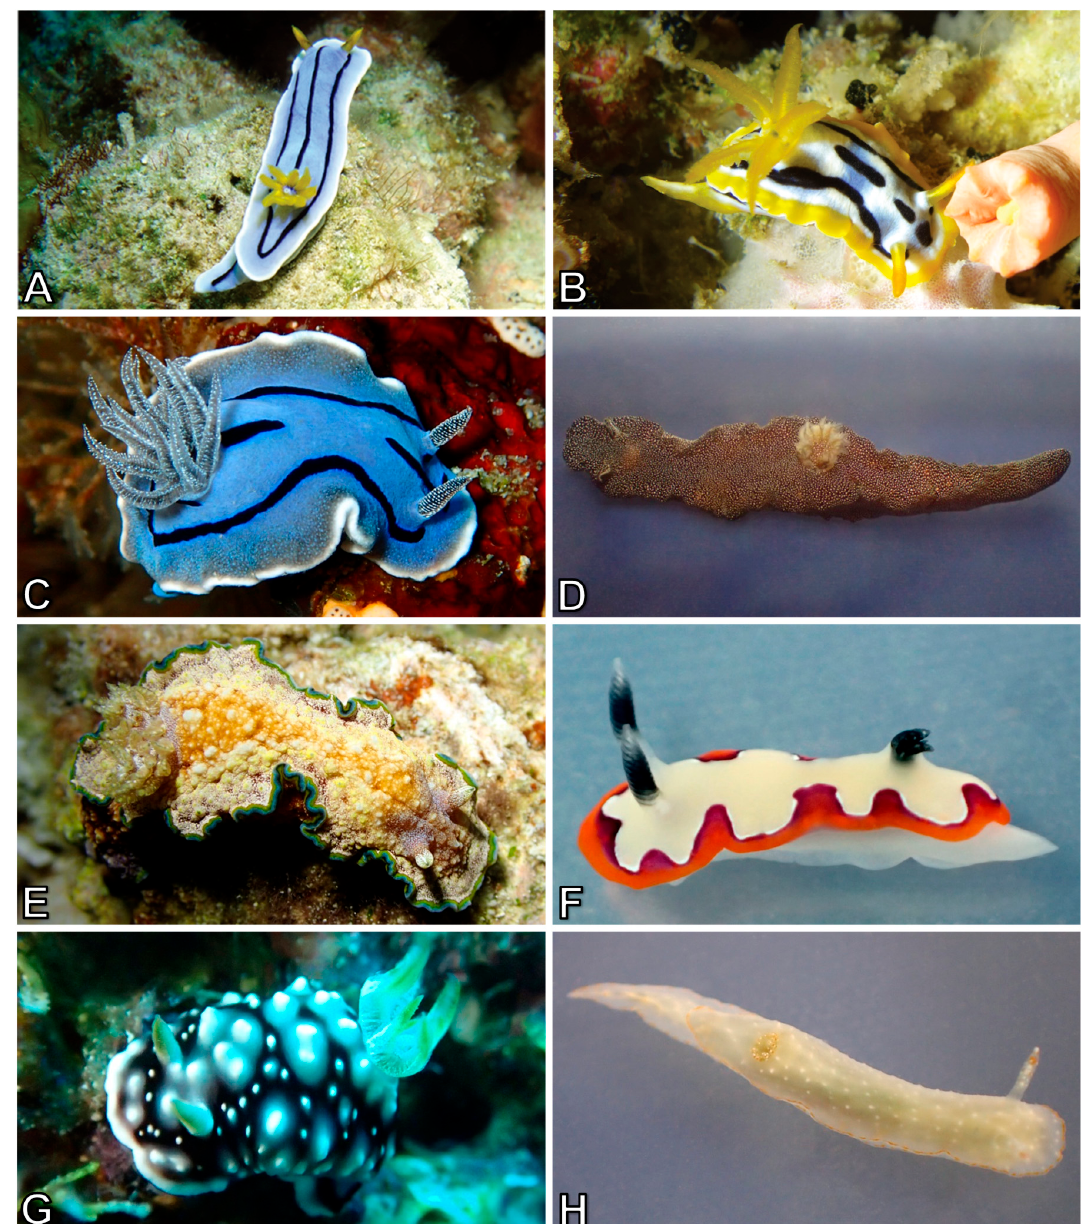
Figure 9. Nudibranchia - Doridina: ( A ) Chromodoris lochi; ( B ) Chromodoris cf. michaeli; ( C ) Chromodoris willani; ( D ) Doriprismatica stellata; ( E ) Glossodoris cincta; ( F ) Goniobranchus fidelis; ( G ) Goniobranchus geometricus; ( H ) Goniobranchus spec. (Goniobranchus sp. 40 in Gosliner et al. [11]: 230), Gosp40_16Bu-1.